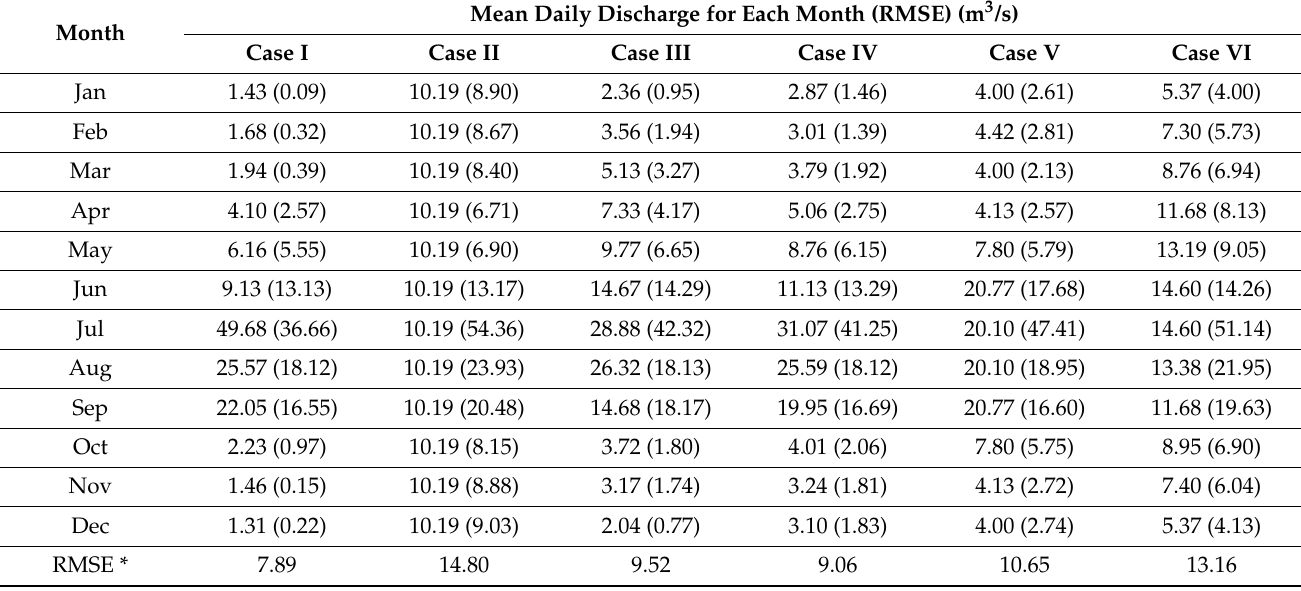
* Averaged root mean square error (RMSE) (m 3